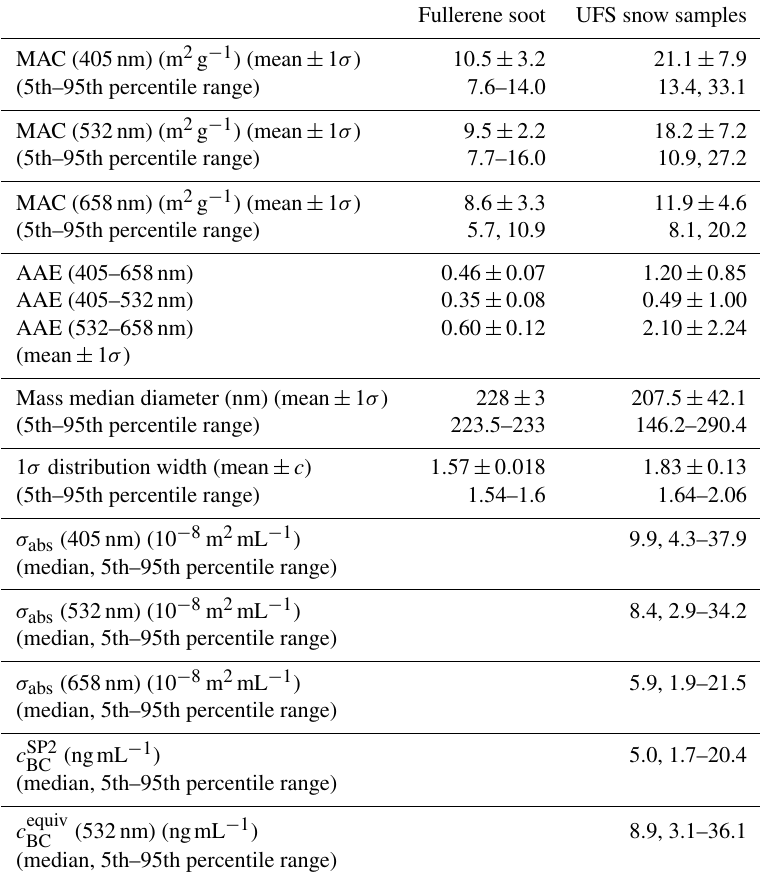
Table 1. Overview of the optical and BC mass properties measured for the fullerene soot suspension standards as well as the fresh snow